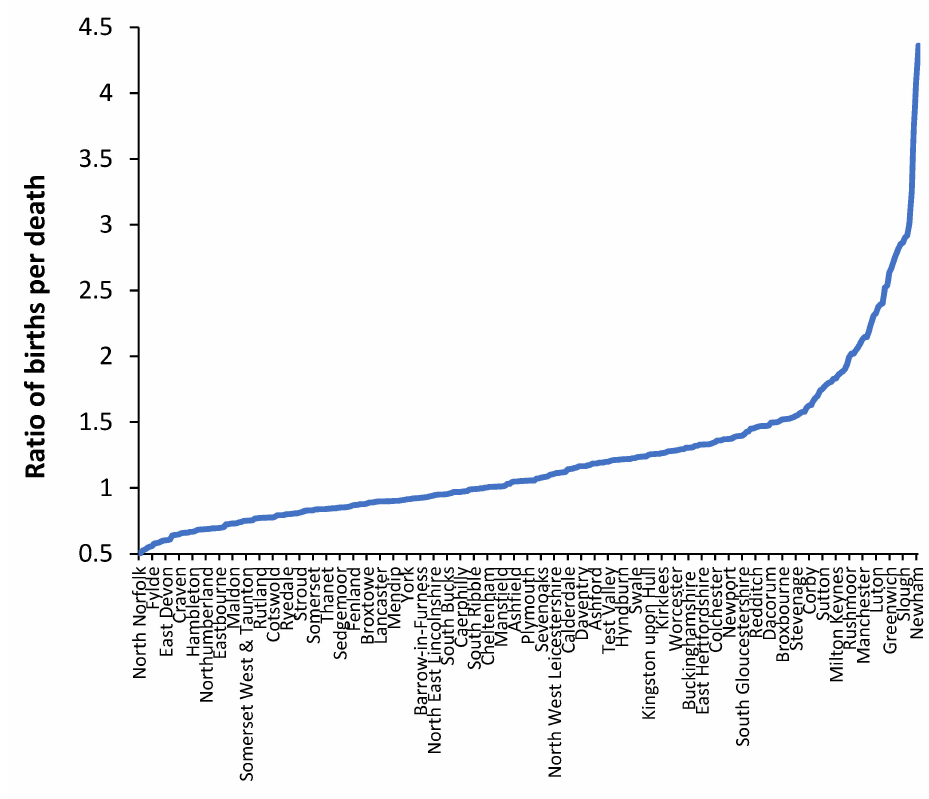
Figure 3. Ratio of births per death for English and Welsh local authorities in